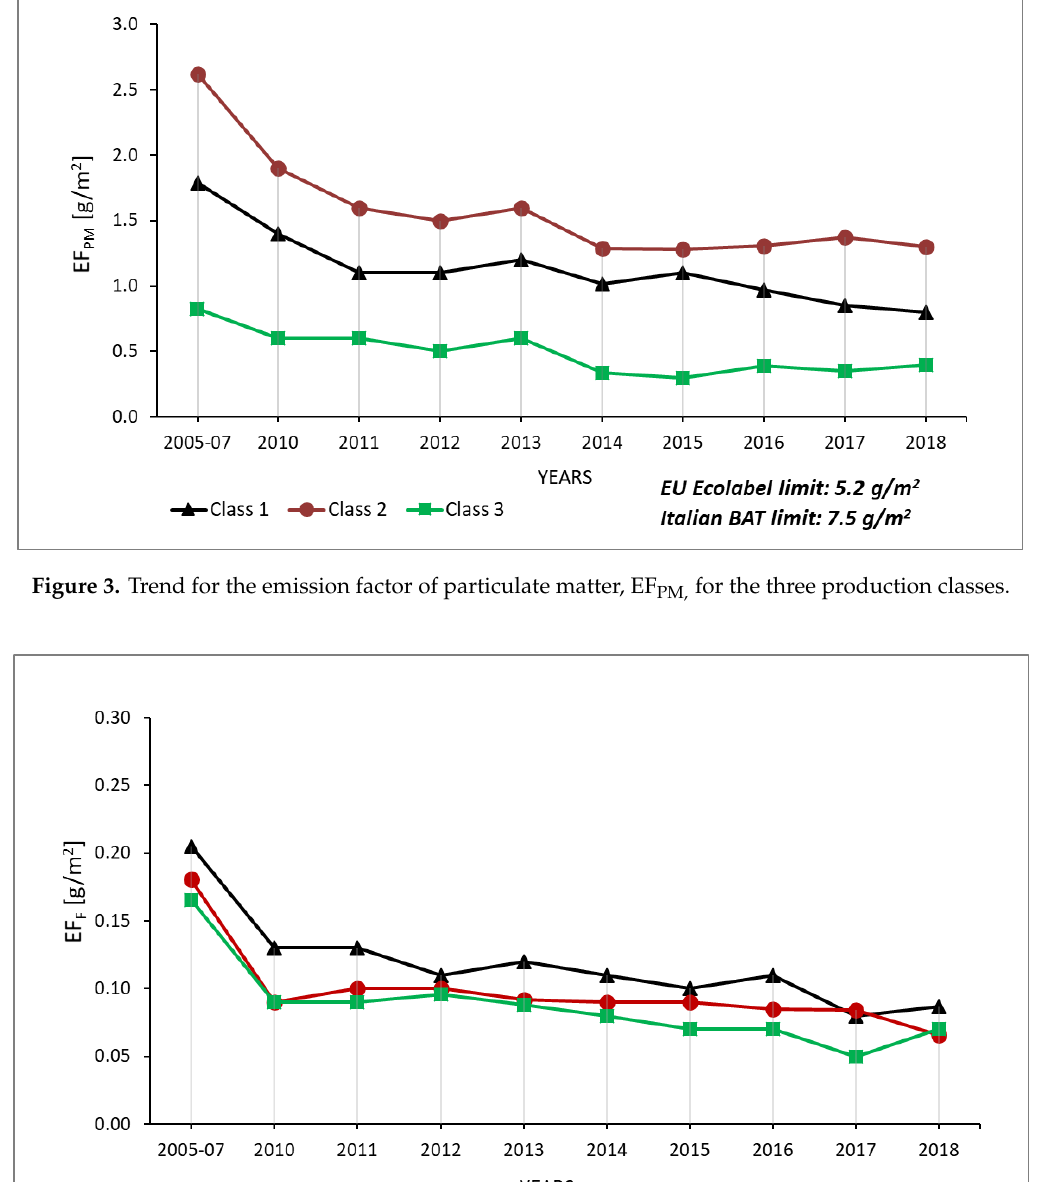
F ) for the three production